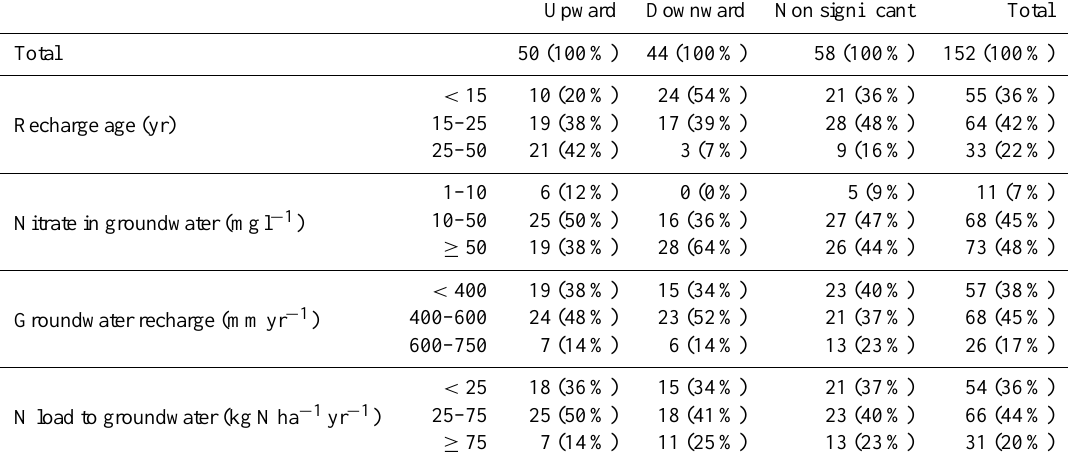
Table 3. Amount (%) of statistically significant upward, statistically significant downward and non-significant nitrate trends in 152 oxic CFC- dated groundwater monitoring points with a 95% confidence level. The nitrate trends are grouped according to (1) groundwater recharge age, (2) the average nitrate concentrations in groundwater, (3) the annual groundwater recharge, and (4) the N load to groundwater. Upward Downward Non significant Total Total 50 (100%) 44 (100%) 152 (100%) < Recharge age (yr)